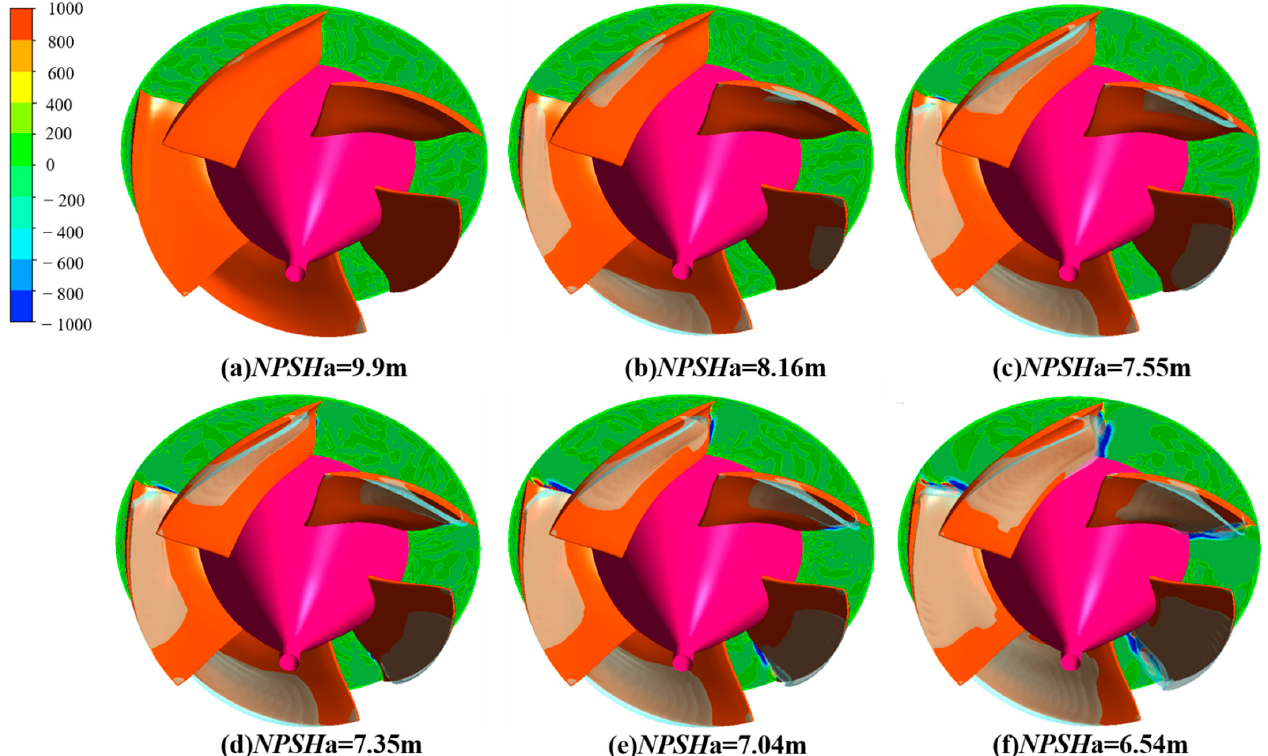
Figure 16. The cavitation region and the contours of the baroclinic torque term on the spanwise section near TE. section near